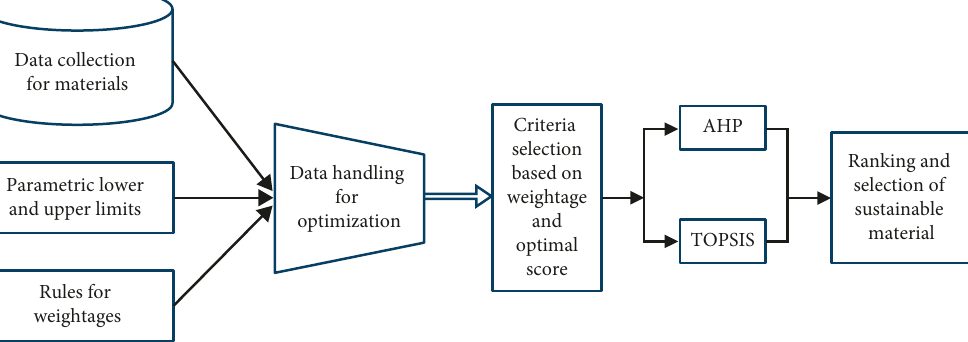
Figure 1: OSM and AHP-TOPSIS-based framework for selection of sustainable supplementary concrete material. Table 2: Candidate materials for shortlisting of supplementary concrete material.